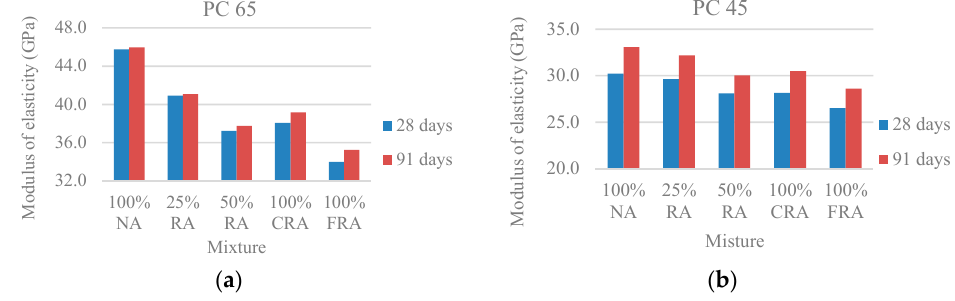
Figure 9. ( a ) Modulus of elasticity at 28 and 91 days (PC 65); ( b ) Modulus of elasticity at 28 and 91 days (PC 45). Table 10. Modulus of elasticity versus compressive strength according to EC2 [32] at 28 and 91 days (PC 65).